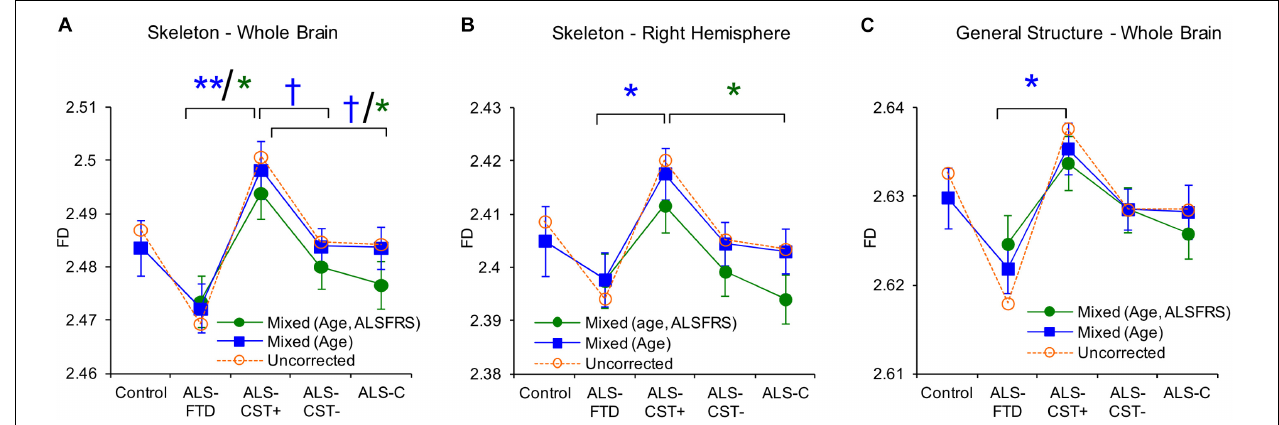
FIGURE 7 | Between group comparisons show significant differences in fractal dimension values of skeleton-whole brain (A) , skeleton right hemisphere (B) , and general structure whole brain (C) . Uncorrected means are represented as dashed lines and corrected means (mixed model) and standard error of the mean are shown as solid lines. Data for mixed models with gender, age as covariates are shown in blue or with gender, age, and ALSFRS-R as covariates are in green. Corrected mean comparisons between groups are performed using the Tukey multiple comparison method. † p < 0.1, ∗ p < 0.05, ∗∗ p < 0.001. Reproduced with permission from PlosOne